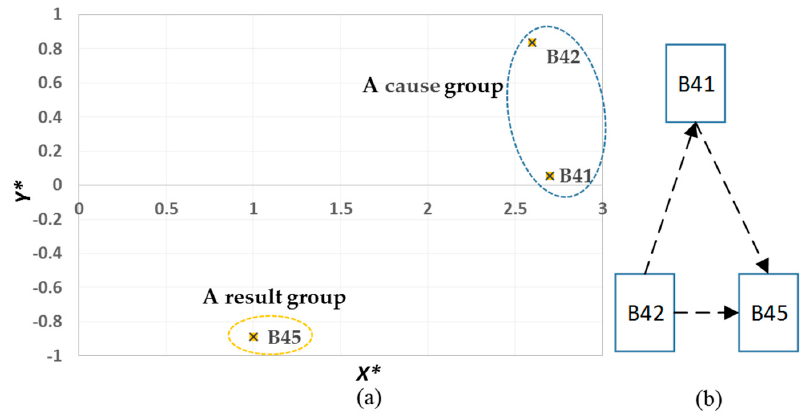
sub-criteria and ( b ) obvious cause and effect relations.